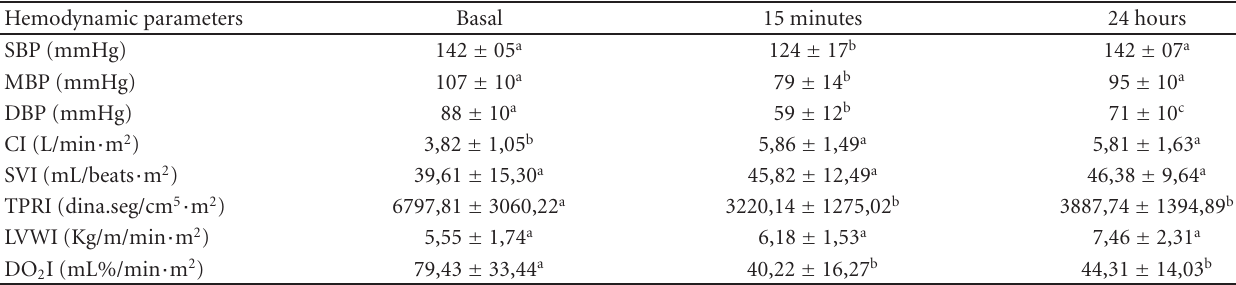
Table 1: Mean values ± standard deviations of hemodynamic parameters obtained from dogs ( n = 10) before (Basal) and 15 minutes and 24 hours after induction of acute normovolemic anemia.